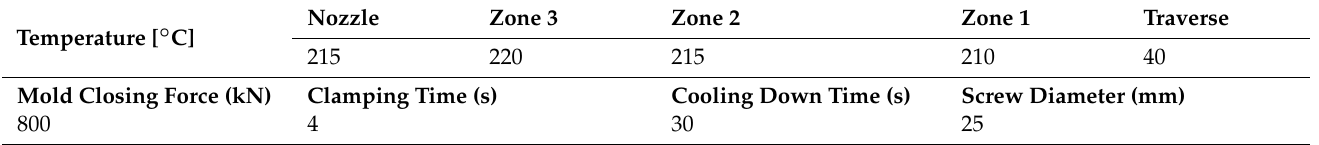
Table 2. Injection moulding parameters.